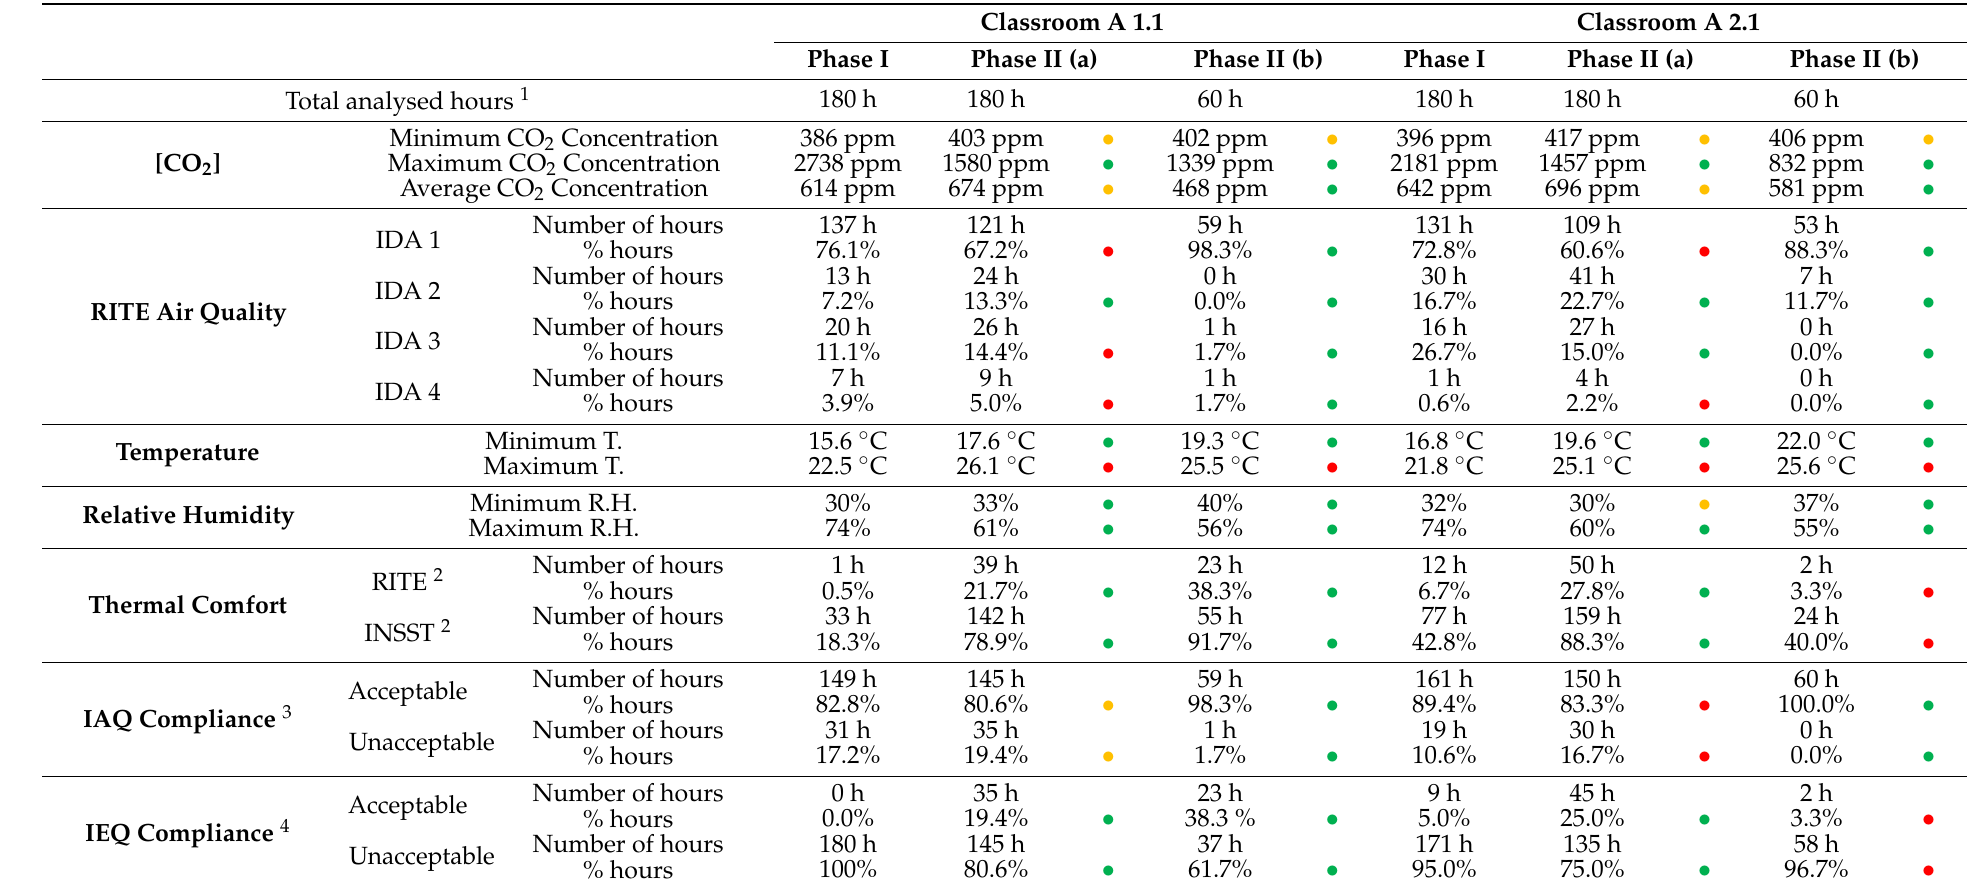
Table 4. Summary of results and phase comparison table for classrooms A 1.1 and A